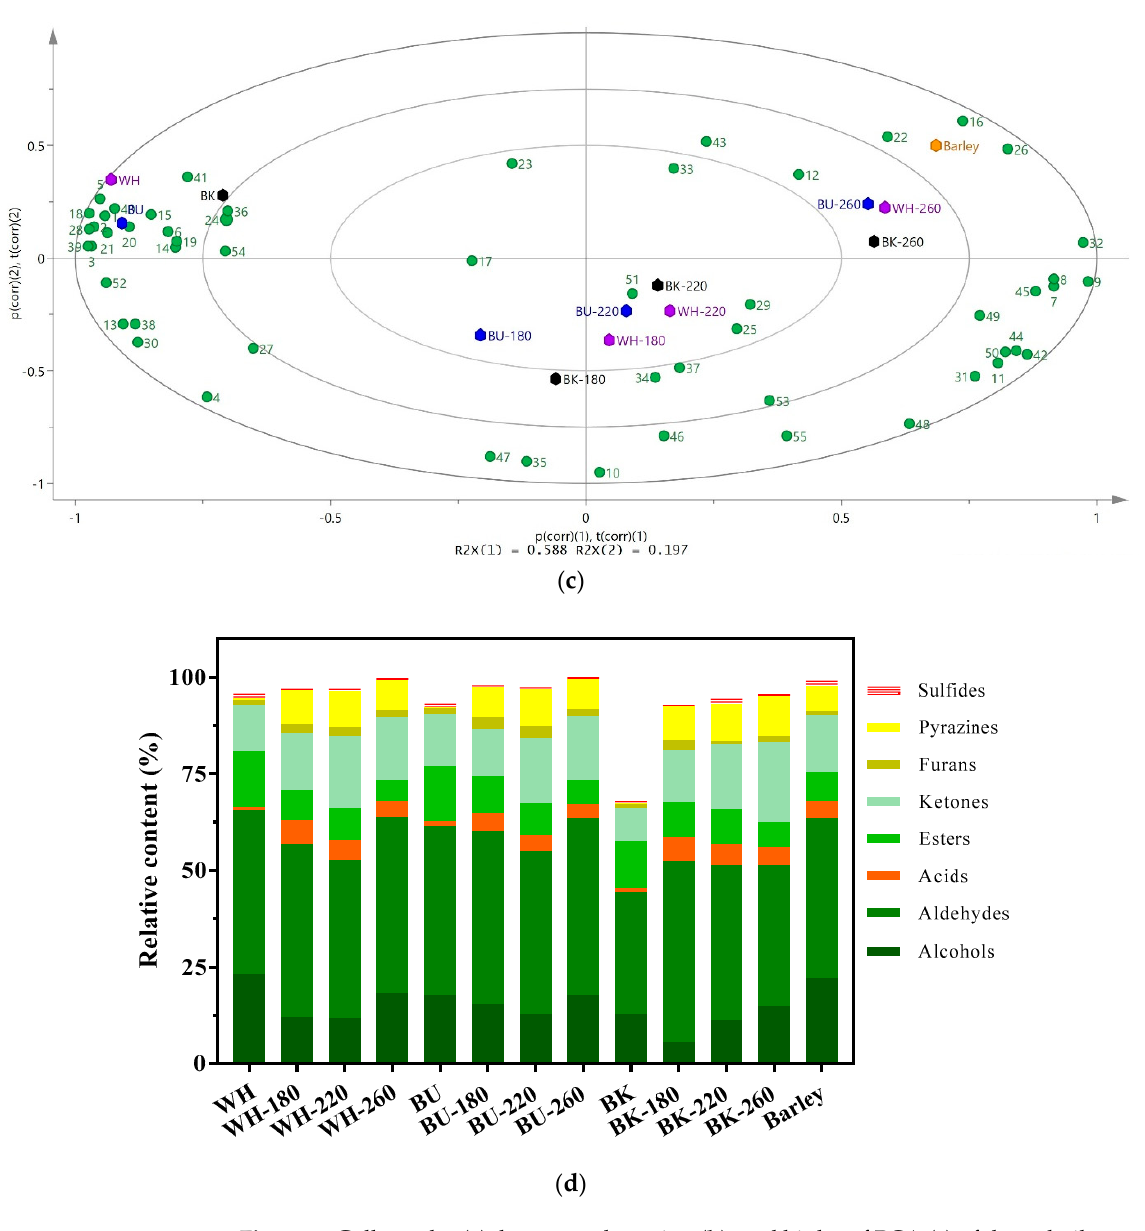
Figure 2. Gallery plot ( a ), heatmap clustering ( b ), and biplot of PCA ( c ) of the volatile compounds attributed by HS-GC-IMS and the relative contents of volatile substances ( d ) of the raw and CHB roasted at different temperatures. The numbers in the biplot were consistent with that of the identifiers listed in Table 2.